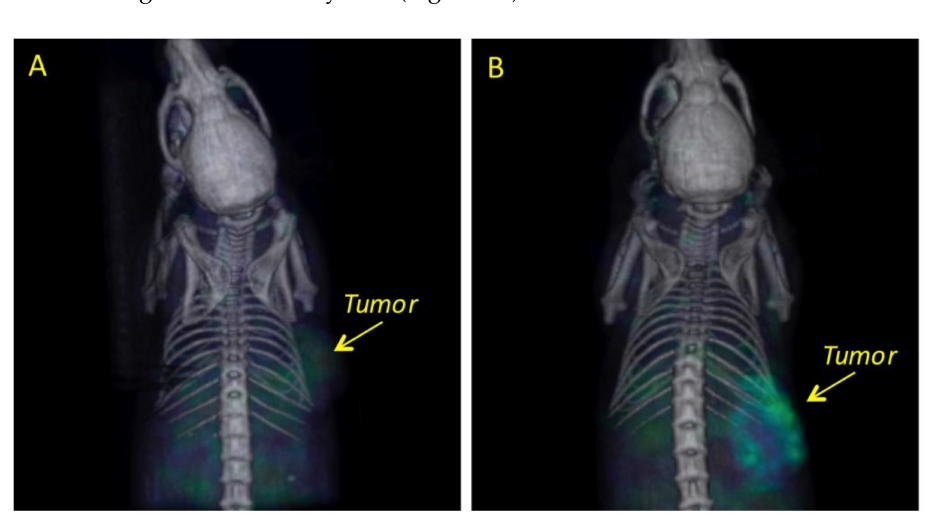
Figure 4. Representative SPECT/CT 3D-images showing the differences in biodistribution and uptake in mesothelioma xenografts at 24 h post-injection for: ( A ) 67 Ga (control group) and ( B ) 67